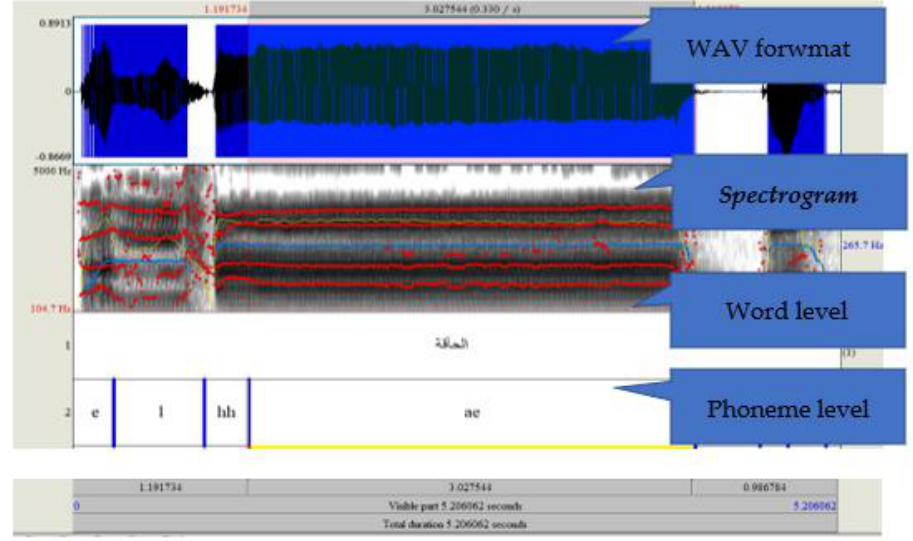
Figure 7. Praat Editor window.